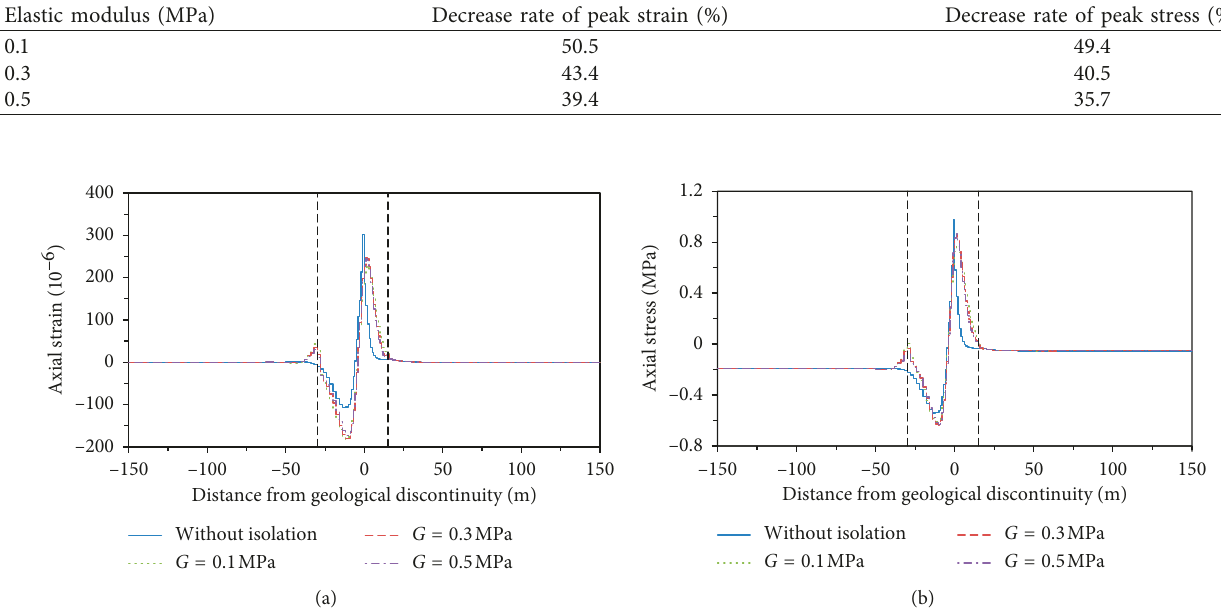
Figure 15: Analysis results along the transverse direction. (a) Axial strain and (b) axial